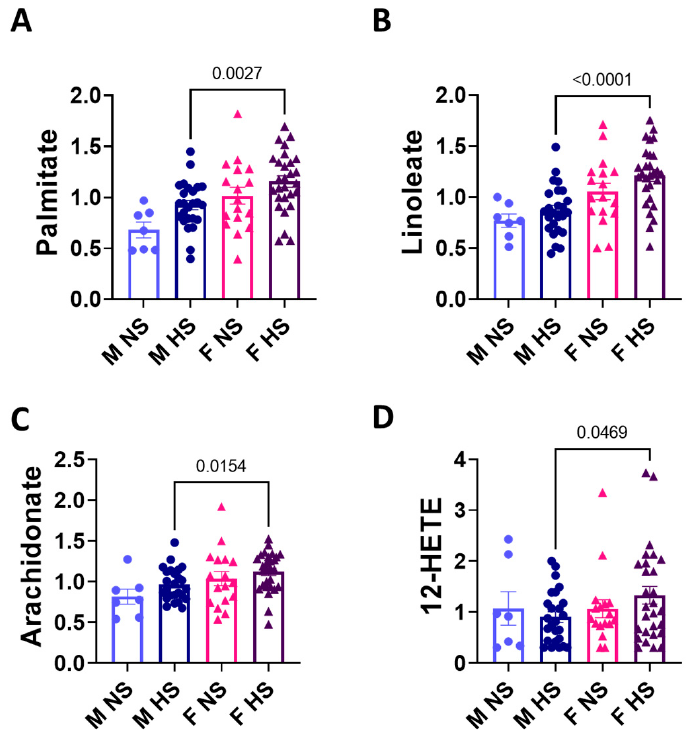
Figure 5. Sex differences in metabolites related to arachidonic acid signaling. ( A ) Palmitate, ( B ) Linoleate, ( C ) Arachidonate and ( D ) 12-HETE in men and women on a normal or high salt diet. M: male; F: female; NS: normal salt; HS: high salt; 12-HETE: 12-Hydroxyeicosatetraenoic acid. p -values were determined using 2-tailed unpaired Student’s t tests. M NS: men normal salt ( n = 7); M HS: men high salt ( n = 24); F NS: women normal salt ( n = 16); and F HS: women high salt ( n = 28).